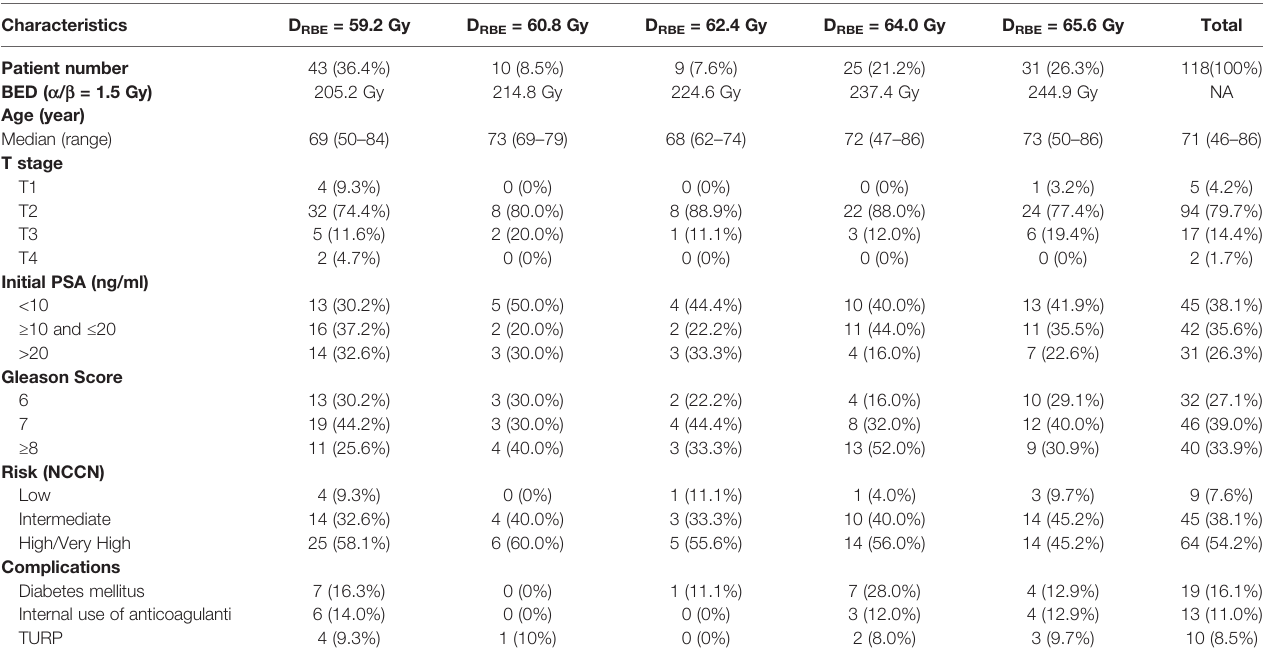
TABLE 1 | Patients ’